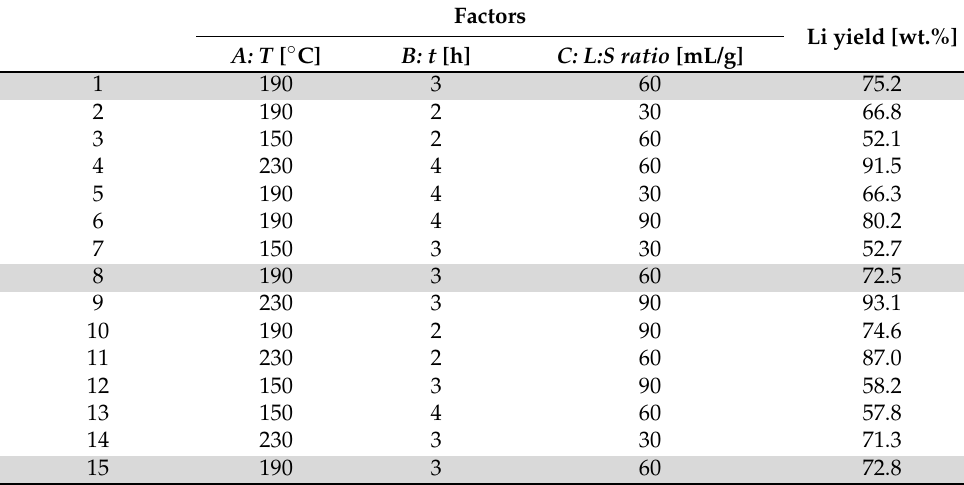
Table 3. Li yield in each experiment obtained experimentally following the 3 3 Box-Behnken experi- mental design ( A : T [ ◦ C], B : t [h], C : L:S ratio [mL/g]). The experiments shaded in grey correspond to the replicated central point.